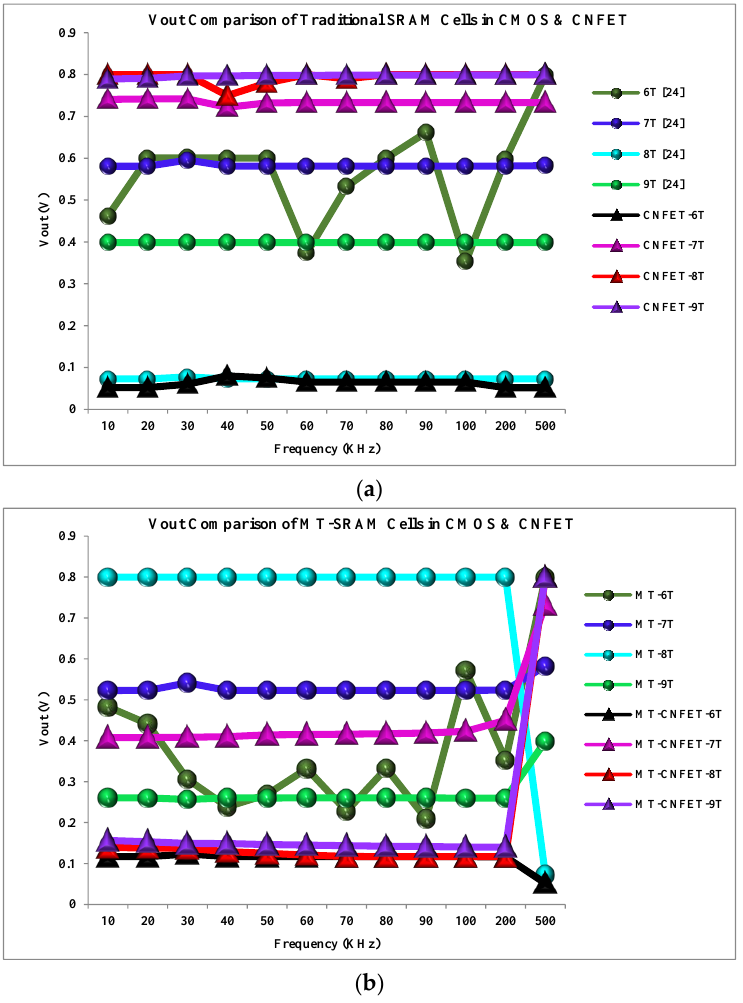
Figure 11. ( a ) Vout Comparison of Traditional SRAM Cells in CMOS and CNFET. ( b ) Vout Comparison of Proposed MT-SRAM Cells in CMOS and CNFET. Table 3. Vout Improvement (%)–Traditional CNFET 6T SRAM Cell vs. Other SRAM Cells.